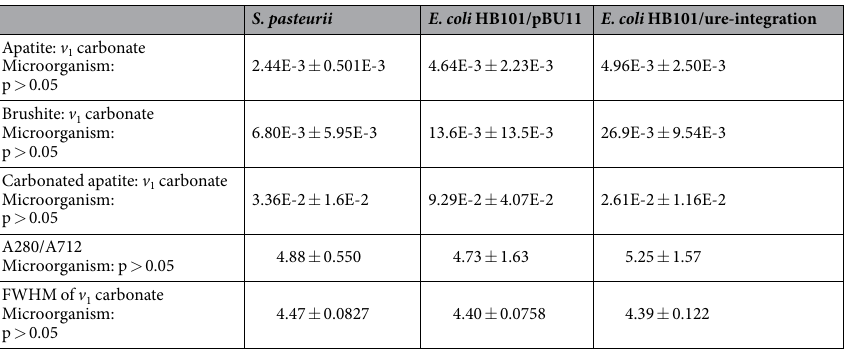
Table 2. Measures from Raman spectroscopy for biocalcite crystals. Data are presented as mean + / − standard error of the mean. One-way ANOVA result for the main effect of microorganism is reported in the left